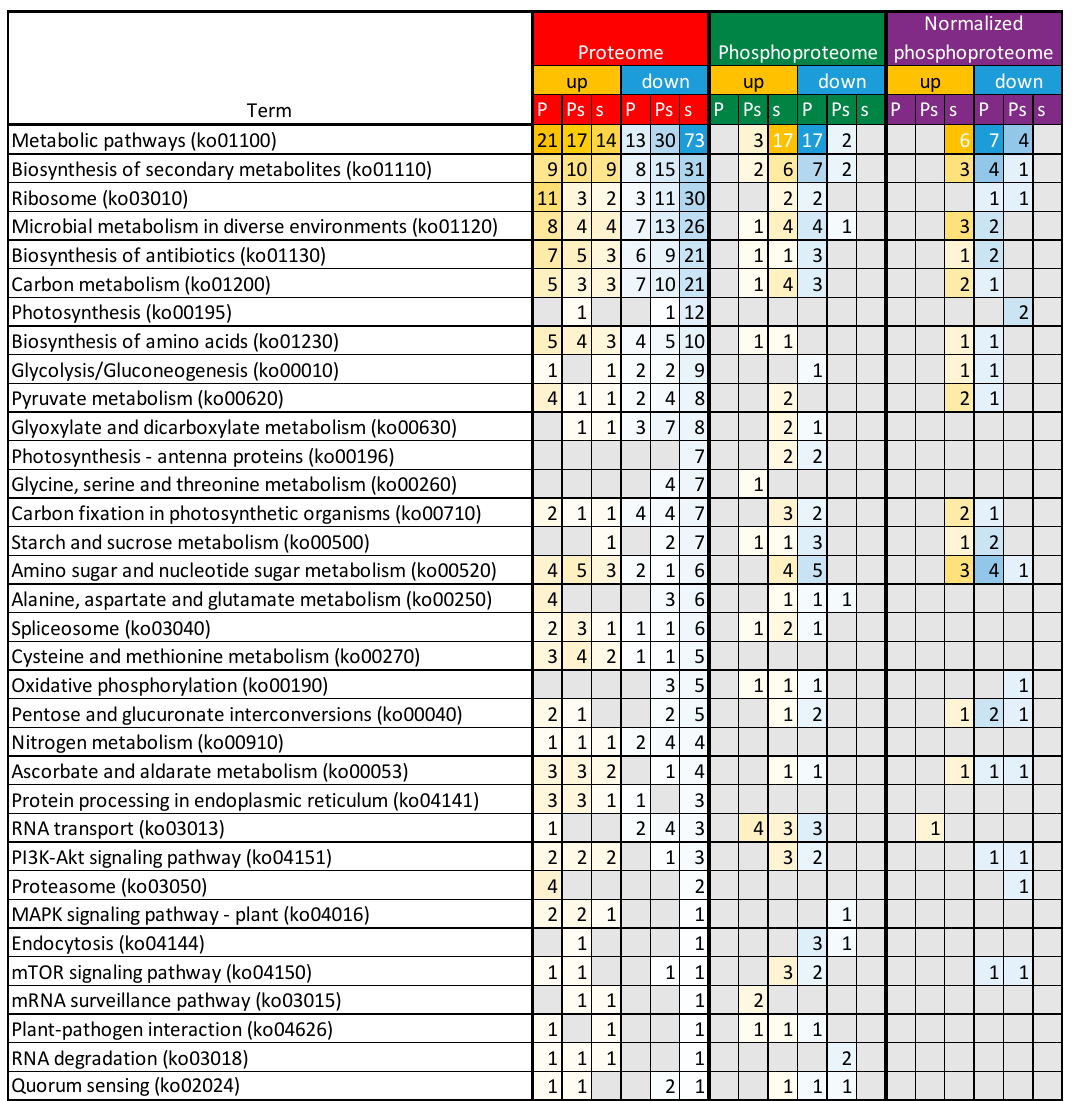
Figure 4. KEGG Automatic Annotation Server (KAAS) analysis. Analysis conducted separately on down- and up-regulated (phospho)proteins during PSV-P and PSV-P and satRNA infection of N. benthamiana plants using Blast2GO Pro. P—PSV-P-responsive, Ps—PSV-P and satRNA-responsive,